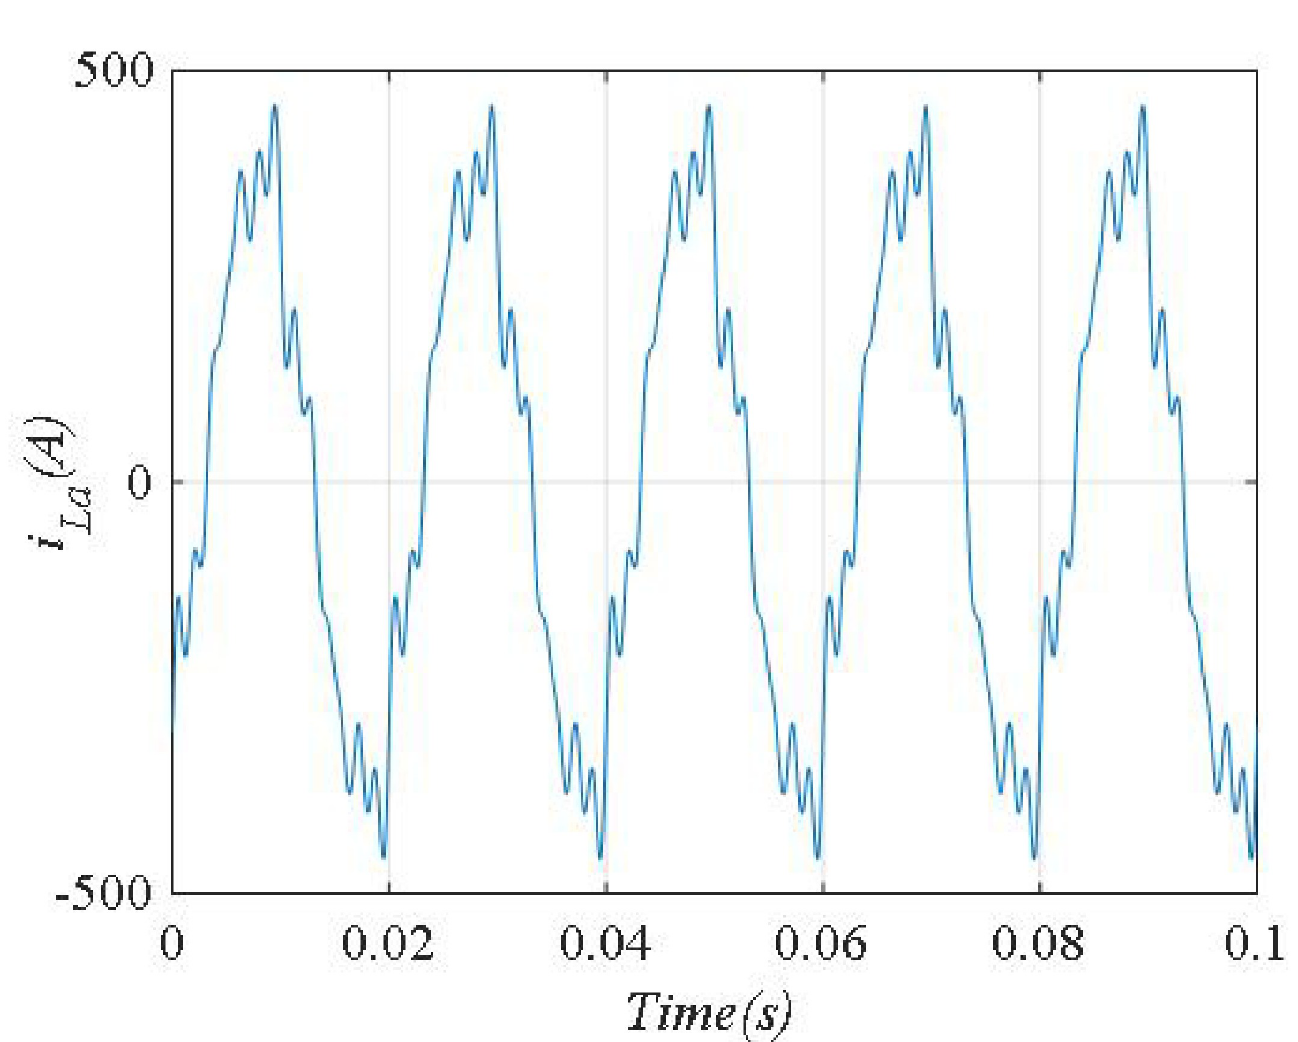
Fig 4. Load current